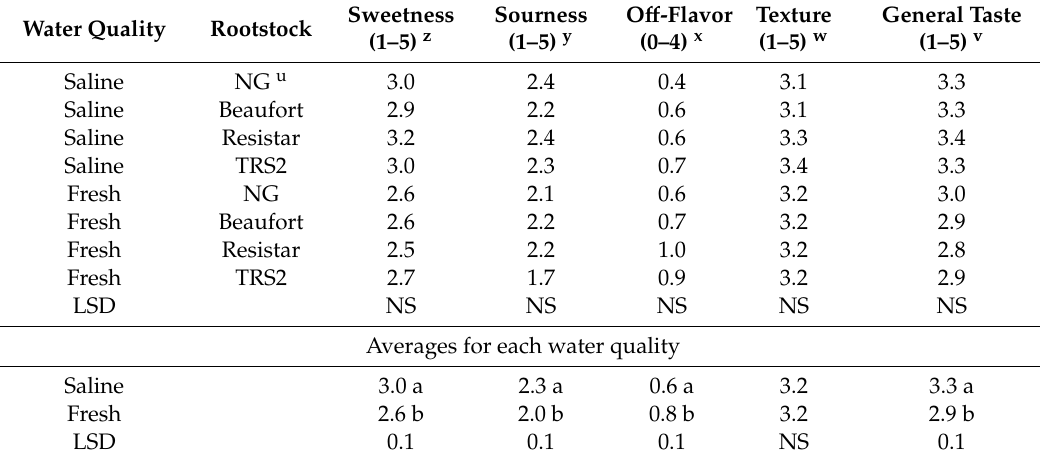
Table 4. Influence of water quality and grafting on sensory parameters obtained by hedonic tests in cherry tomato fruit after storage for 12 d at 12 ◦ C and 2 d at 20 ◦ C (Means of 5 harvests). Water